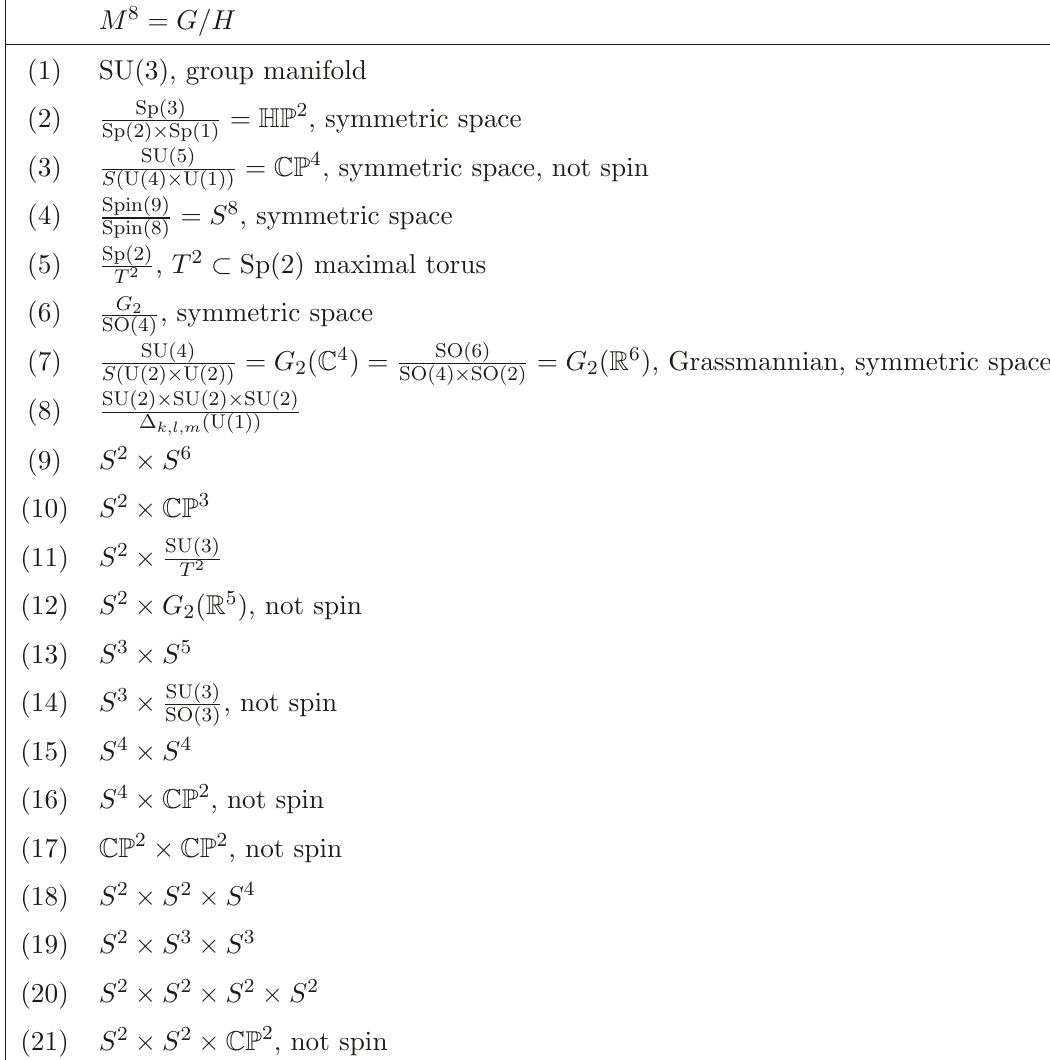
Table 2 . 8-dimensional compact, simply connected, homogeneous